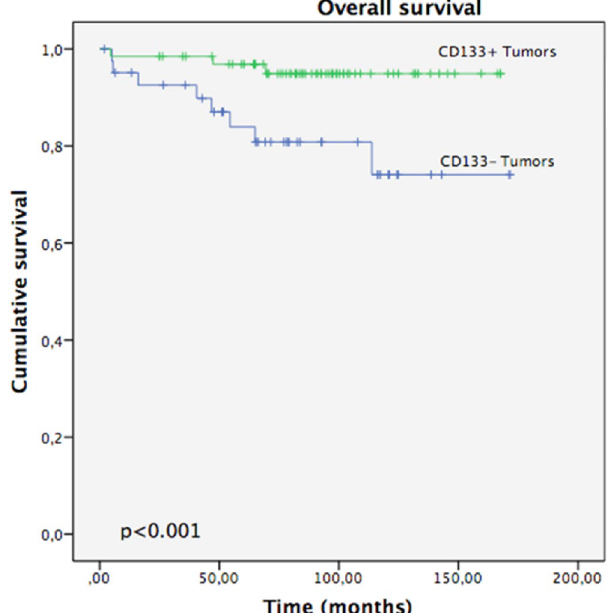
Figure 3. Overall Survival: CD133 + vs CD133 − Tumors.